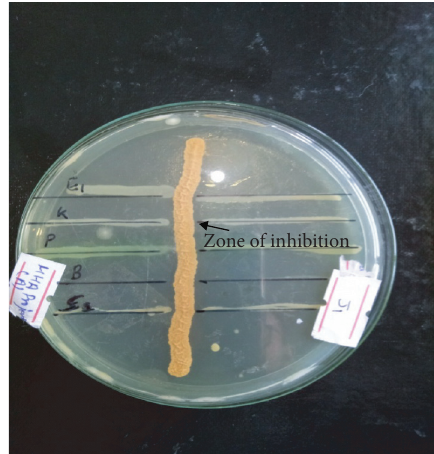
Figure 5: Primary screening of isolates. Subcultured isolates streaked line on the Mueller Hinton Agar (MHA) which was screened against different bacteria, (E) E. coli , (K) Klebsiella pneumoniae , (B) Bacillus species, (S) Staphylococcus aureus, and (P) Pseudomonas aeruginosa (as shown by the